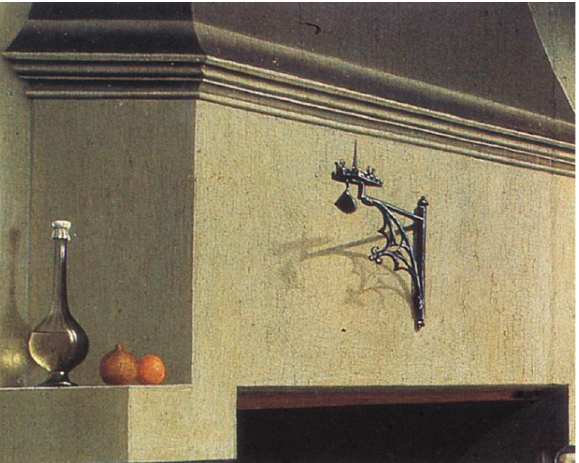
Figure 7. Rogier van der Weyden and workshop, Annunciation (detail). © Wikipedia Commons,